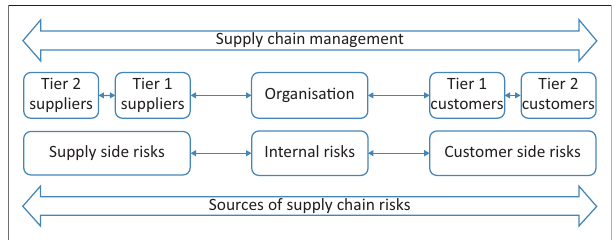
FIGURE 1: Sources of supply chain risk